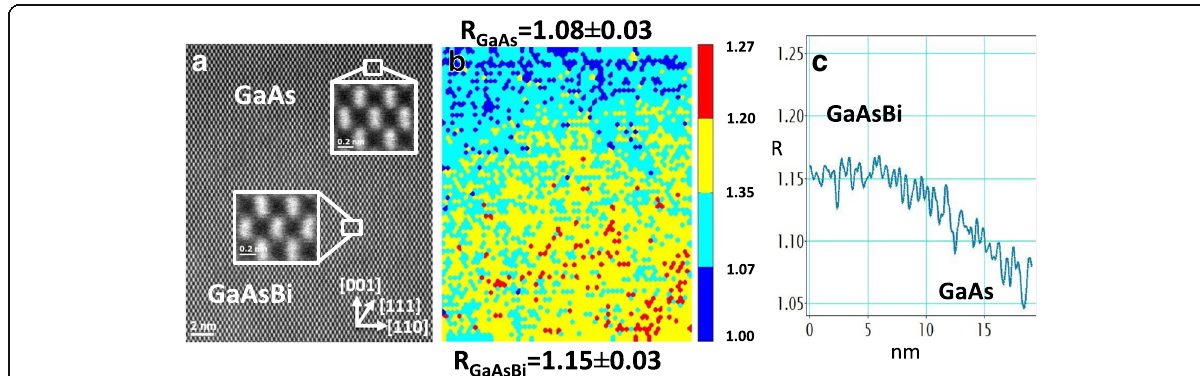
Fig. 3 a Cross-sectional [110] HAADF-STEM image of the interface GaAsBi/GaAs of sample S1. The detail of an undistorted region in the GaAs layer and distorted anion-cation dumbbells in a Bi-rich area at higher magnification are included as an inset in the same image. b Coloured map representing R values around group V columns of the HAADF image in Fig. 3a. The green colour corresponds to mean Bi composition in GaAsBi layer measured by EDX. Despite the homogeneous distribution of Bi in the HAADF-STEM image, the intensity map shows areas with high probability of nanoclustering (red dots) and columns with relative poor Bi content (blue dots) in the GaAsBi layer. c Profile along the growth direction of the whole R intensity map, showing a blurred GaAsBi/GaAs interface in about 10